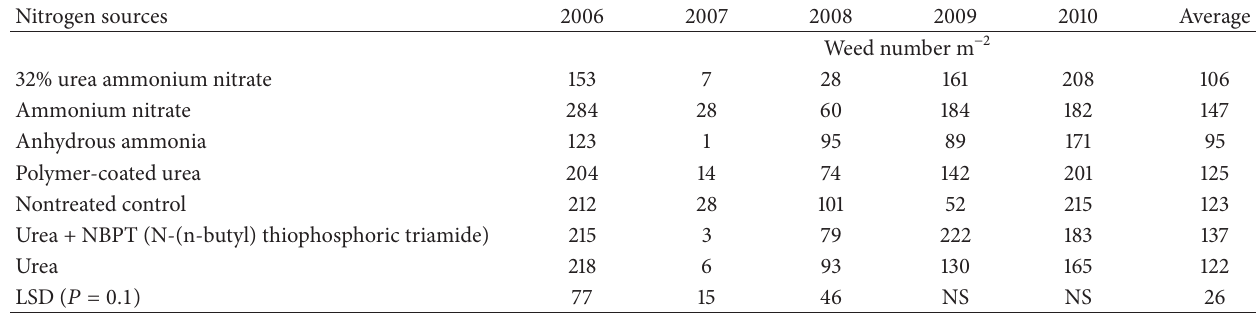
Table 4: Winter annual weed number in the spring following N application timings. Data were averaged over application